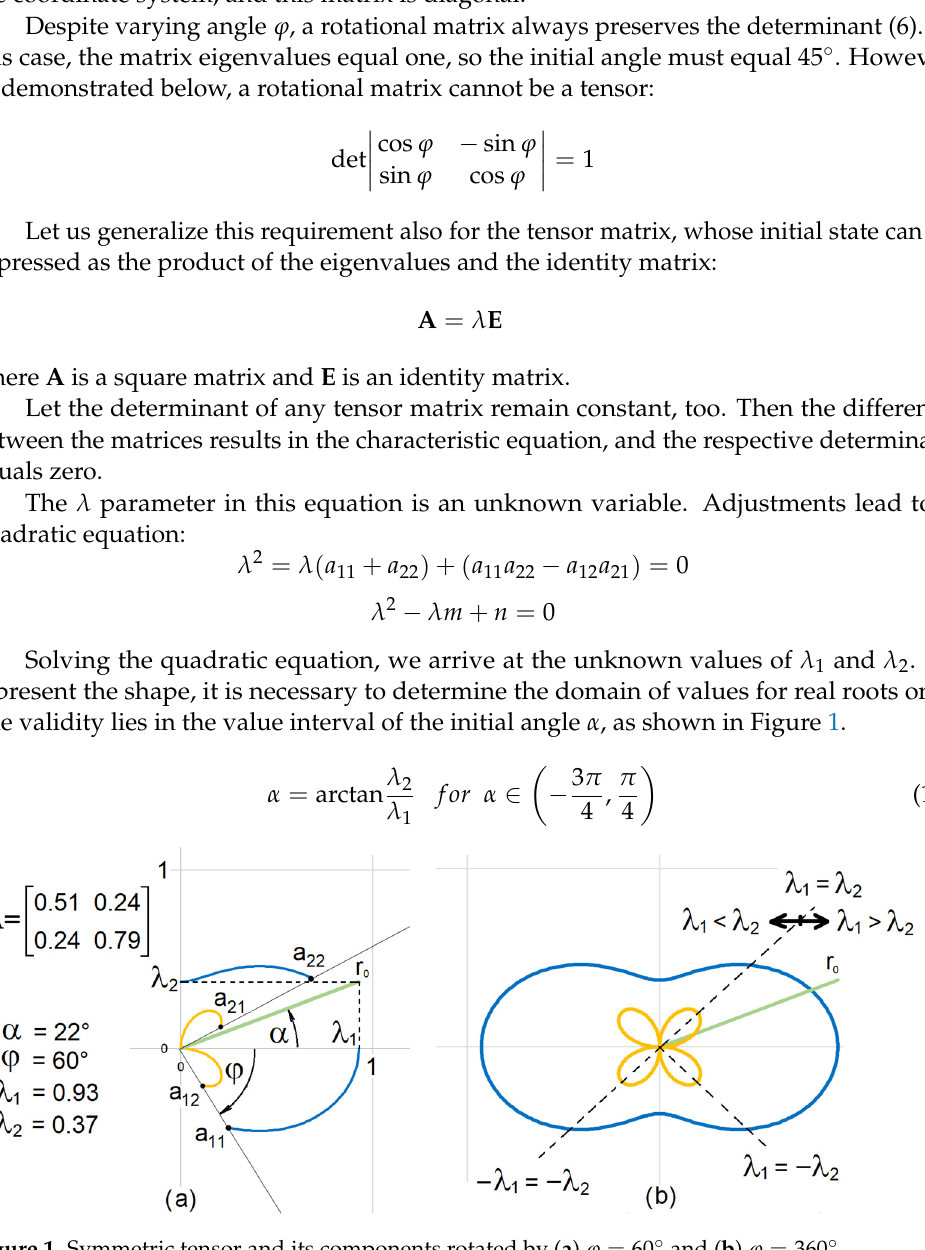
Figure 1. Symmetric tensor and its components rotated by ( a ) 𝜑 = 60° and ( b ) 𝜑 = 360° . Figures 2–4 show symmetric tensor glyphs under various angles 𝛼 .